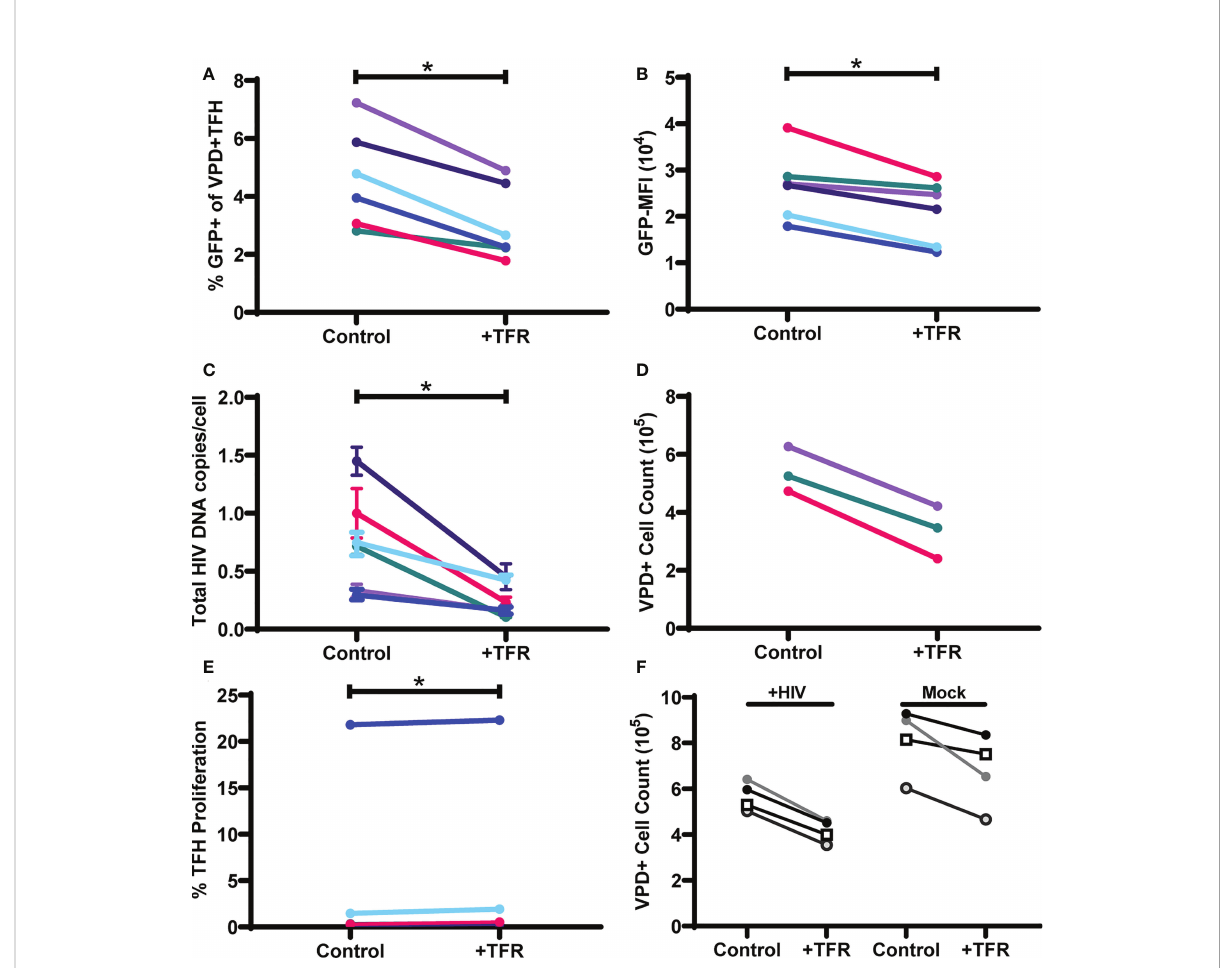
FIGURE 3 TFR reduce HIV expression in and viability of TFH. TFH were spinoculated with CXCR4-tropic HIV GFP reporter virus, labeled with VPD, and cultured for fi ve days at a ratio of 1:1 with uninfected, unlabeled TFH (control) or TFR in media supplemented with 10 IU/ml IL-2 and 5 m M saquinavir (n=6). Percent GFP + (A) and GFP-MFI (B) of live VPD + TFH was assessed by fl ow cytometry after fi ve days using the gating strategy in Figure 1. (C) DNA was isolated from sorted live VPD + TFH and total HIV DNA was quanti fi ed by QPCR. (D) In three of the cocultures, absolute cell counting beads were added to determine total VPD + TFH cell counts. (E) Percentages of proliferating VPD + TFH were assessed by dye dilution in cocultures after 5 days (n=6). (F) In a separate experiment, TFH were spinoculated with CXCR4-tropic as described above. Cell counting beads were added to determine total VPD + TFH cell counts after 5 days in culture (n=4). Statistical analyses were performed using Wilcoxon matched-pairs tests using Graphpad Prism v8 and signi fi cance indicated: